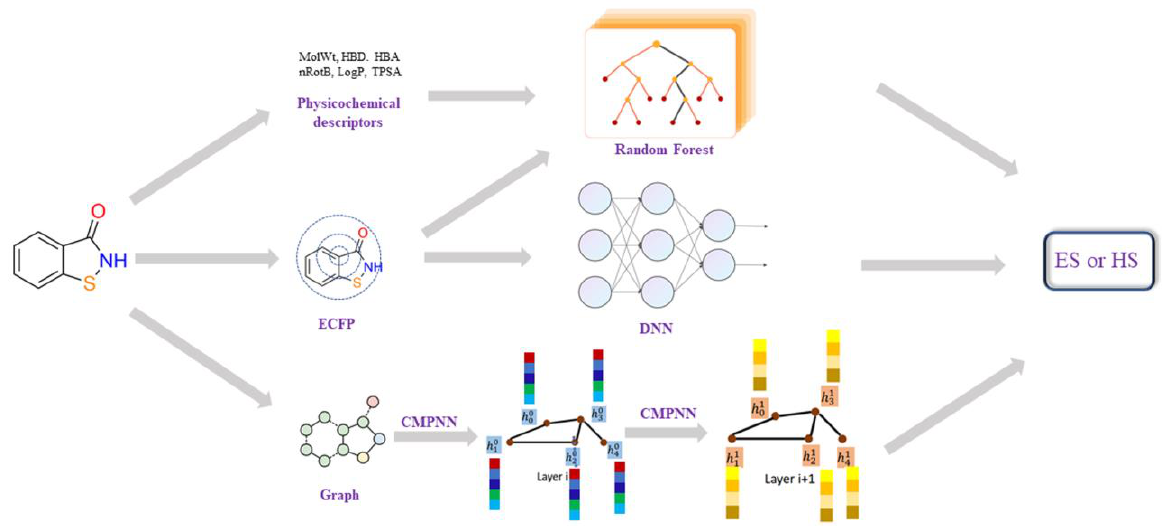
Figure 5. The workflow of different synthesis accessibility prediction models, including: (1) Random Forest model using the physicochemical descriptors; (2) DNN models using ECFP4; (3) graph convolution neural-network-based model using molecular 2D graph structure. Each node (atom) of a graph (molecule) is represented by a feature vector of 133 dimensions, including ‘atomic number’, ‘degree’, ‘formal charge’, ‘number of hydrogens’, ‘hybridization’ and ‘chiral tag’. Then, these node features, together with edge (bond) information, are processed by a Communicative Message Passing Neural Network (CMPNN) to generate a molecular feature.